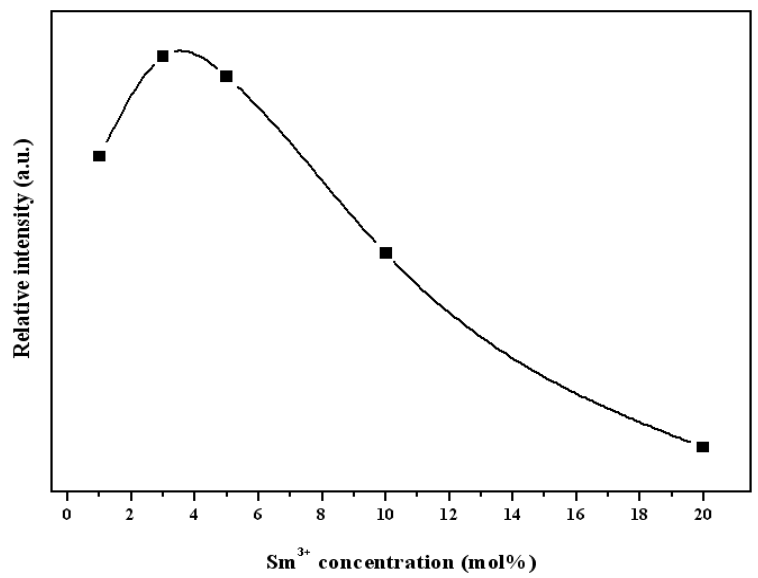
Figure 5. The relationships between the intensity of the emission peak ( 4 G 5/2 → 6 H 7/2 ) and Sm 3+ ion concentrations.